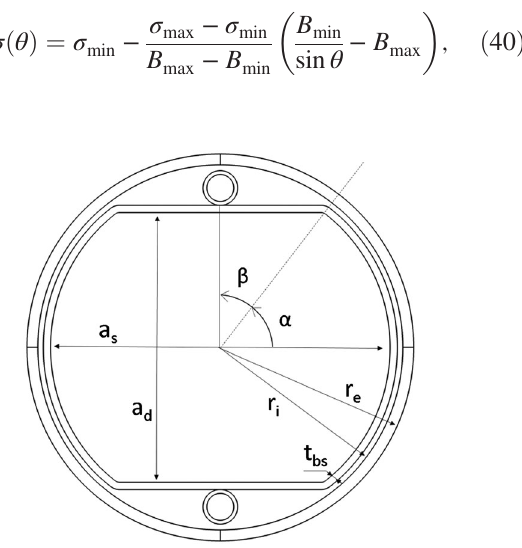
FIG. 15. Frequency response of shielding effect inside the LHC main dipoles. FIG. 16. LHC beam screen cross